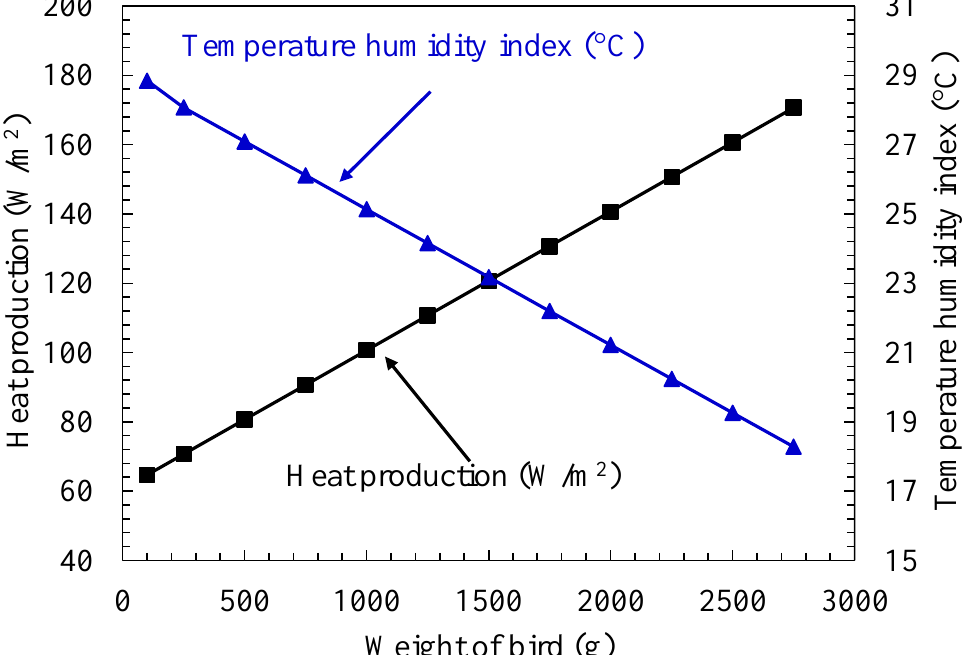
Figure 8. The variations of heat production and THI with respect to weight of poultry birds.